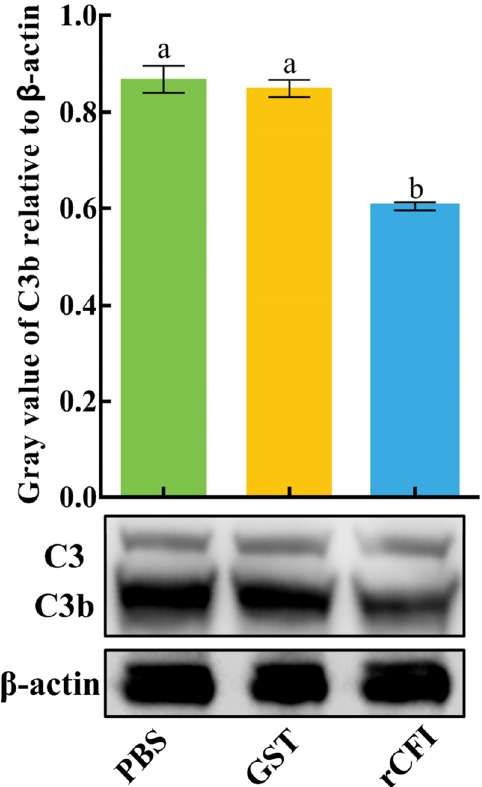
Figure 6. Degradative effect of rCiCFI on the CiC3b in the grass carp serum. Letters a and b indicate significant differences between various experimental groups ( p < 0.05).